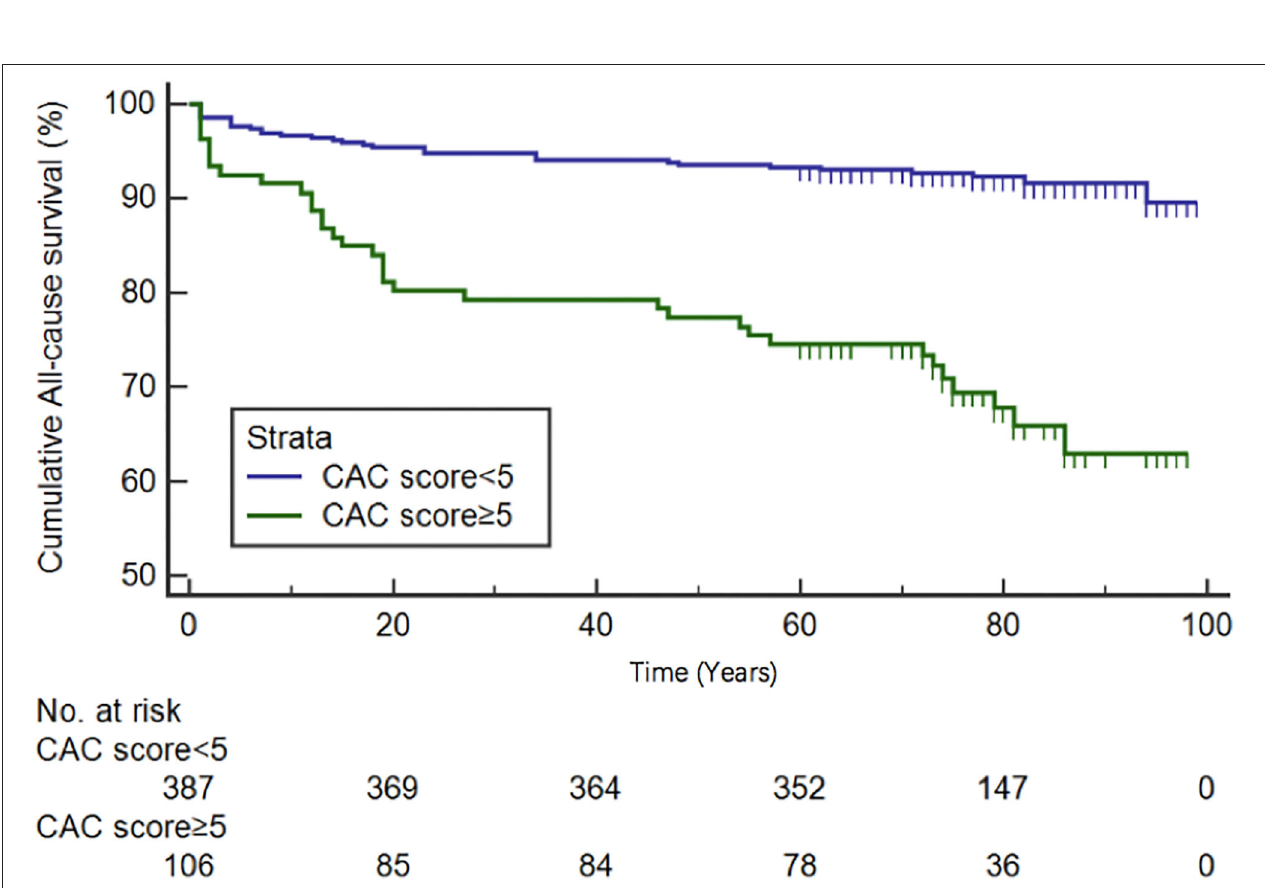
FIGURE 3 | Kaplan-Meier overall survival curves for patients dichotomized by CAC total score ≥ or < 5.